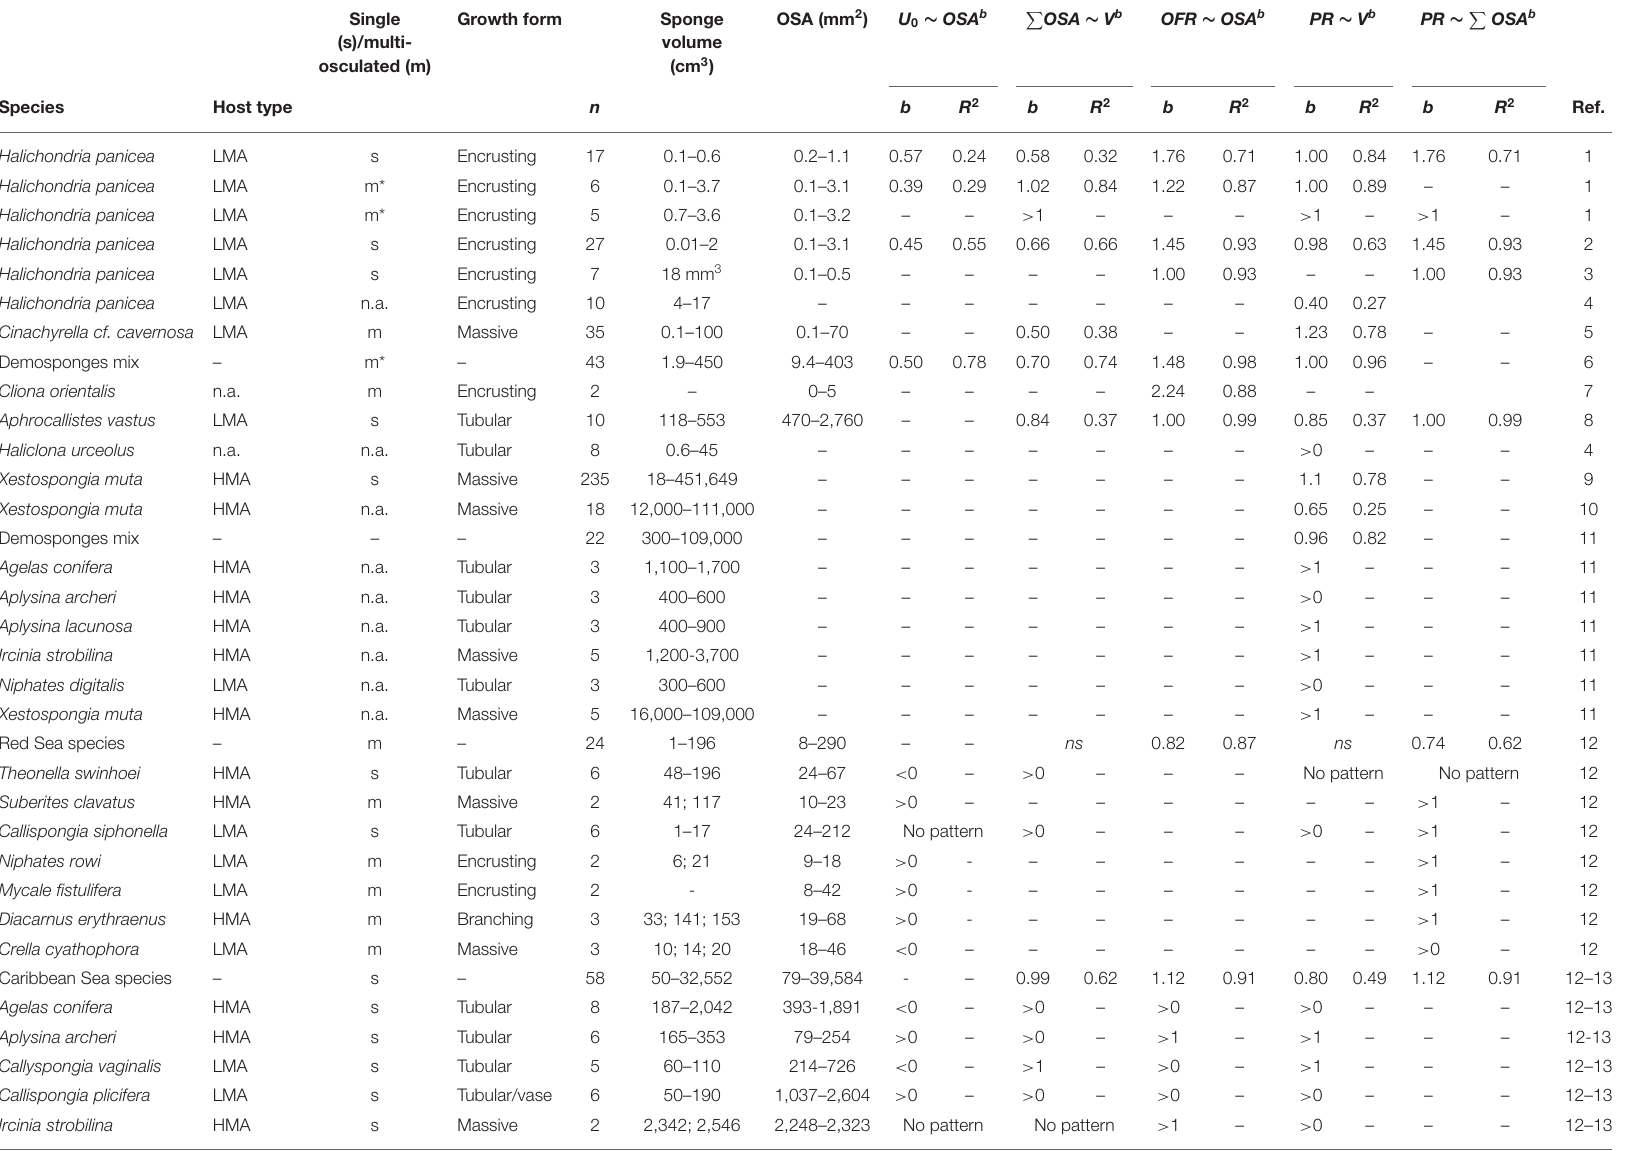
TABLE 4 | Analysis of published data showing the scaling exponents for the allometric function between total osculum cross-sectional area ( P OSA), osculum jet speed (U 0 ), osculum flow rate (OFR), sponge volume (V) and pumping rate (PR). Scaling exponent ( b ) and R squared ( R 2 ) are